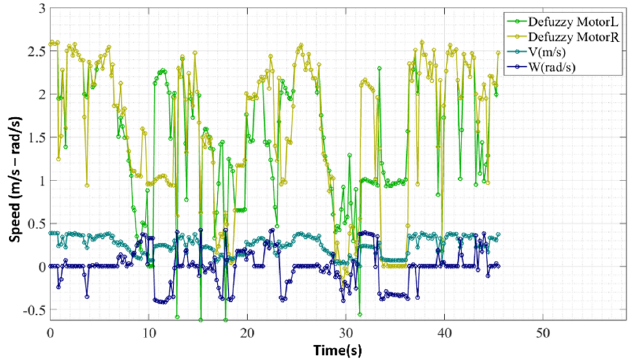
Figure 22. Start of route 3.